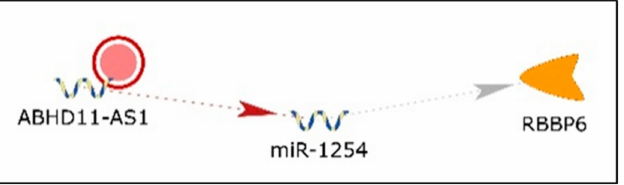
Figure 7. Network 2: ABHD11-AS1 , miR-1254, and RBBP6 , identified in lncRNAs upregulated by miR-29b-1-3p and miR-29a-3p in MCF-7 and/or LCC9 cells by MetaCore analysis. Red line with arrow = inhibition. The dotted gray line is a putative